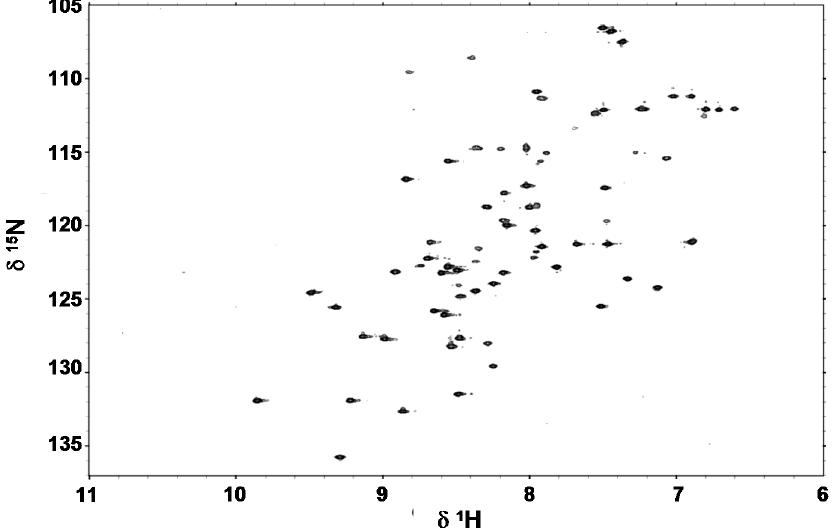
Figure 5. [ 1 H, 15 N] HSQC spectrum (700 MHz) of 13 C, 15 N-labelled Cd 7 wMT-2 (25 °C, 0.5 mM protein, 20 mM NH 4 HCO 3 , pH 6.8, 10% D 2 O). The broad dispersion of backbone N–H crosspeaks, and the narrow peak shapes indicate a well-folded protein.